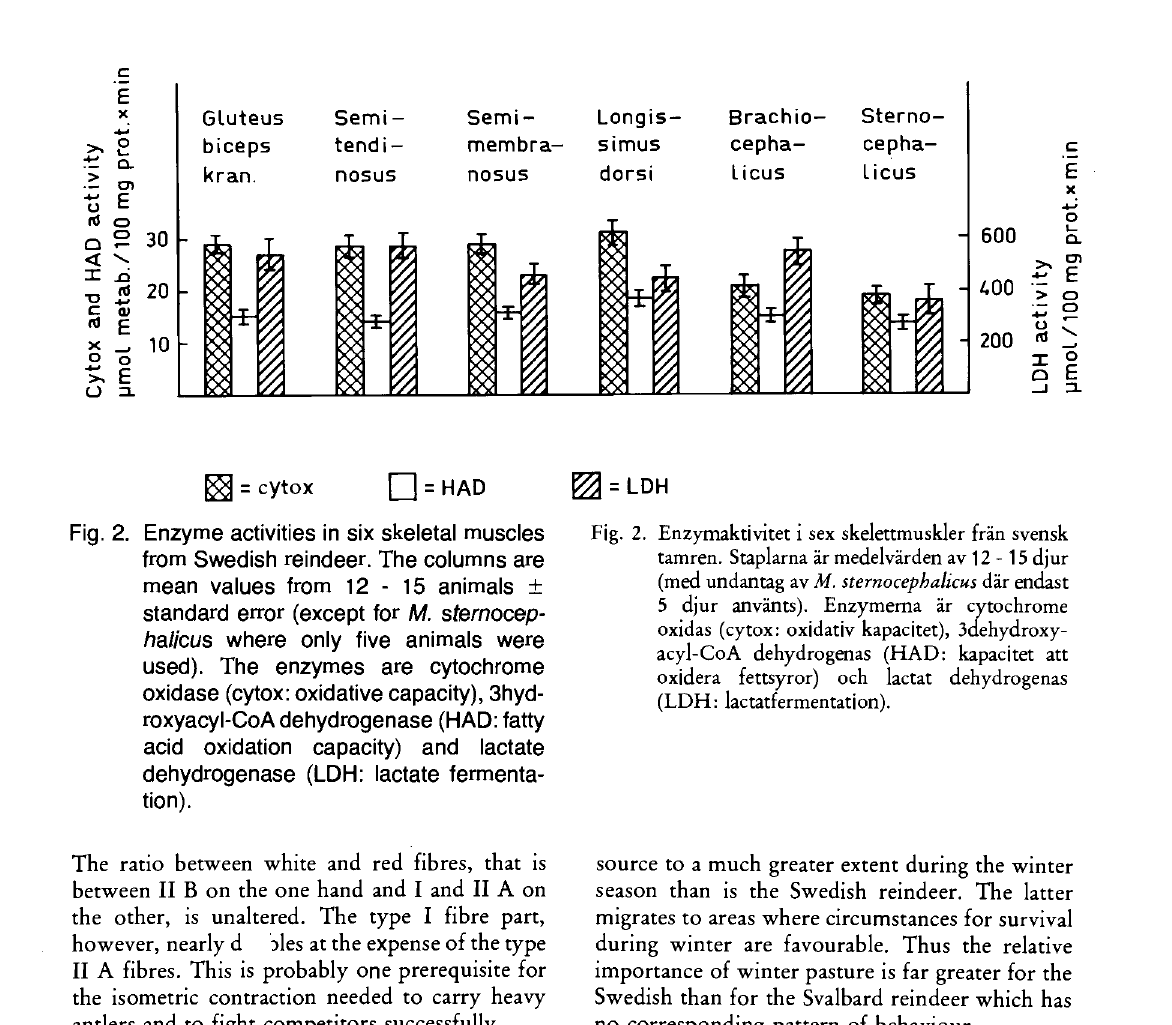
Fig. 2. Enzyme activities in six skeletal muscles from Swedish reindeer. The columns are mean values from 1 2 - 15 animals ± standard error (except for M. sternocep- halicus where only five animals were used). The enzymes are cytochrome oxidase (cytox: oxidative capacity), 3hyd- roxyacyl-CoA dehydrogenase (HAD: fatty acid oxidation capacity) and lactate dehydrogenase (LDH: lactate fermenta tion).